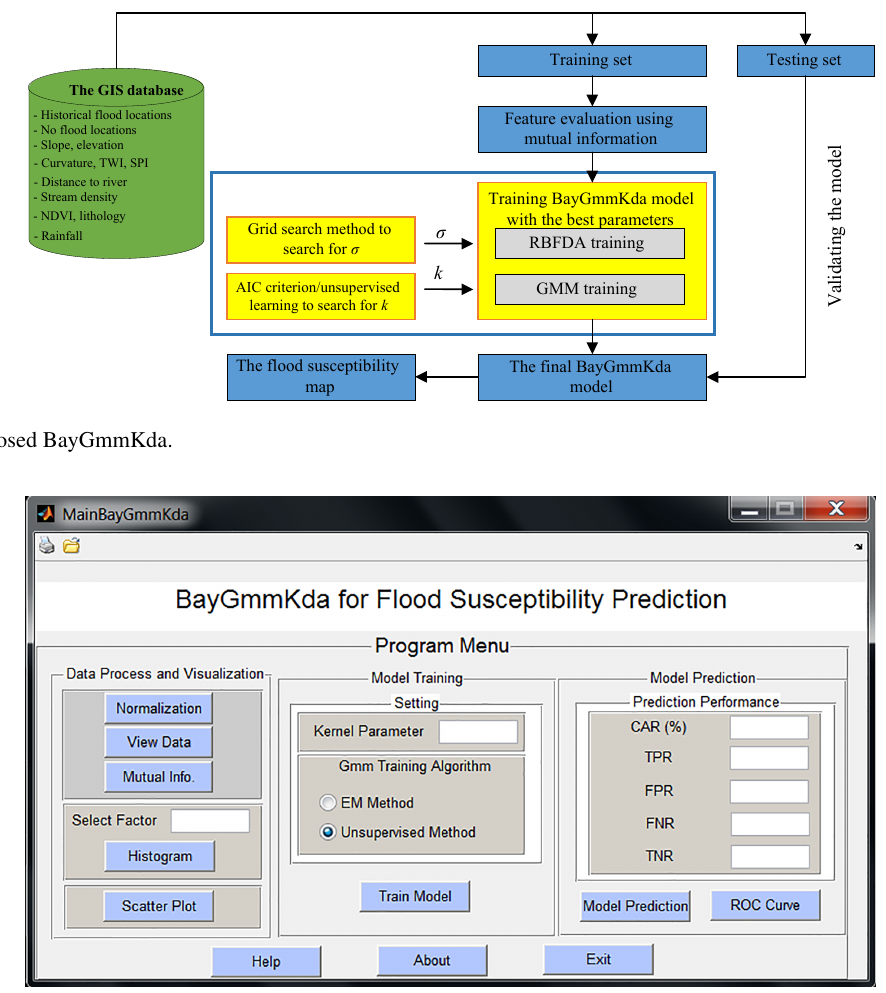
Figure 7. Main menu of